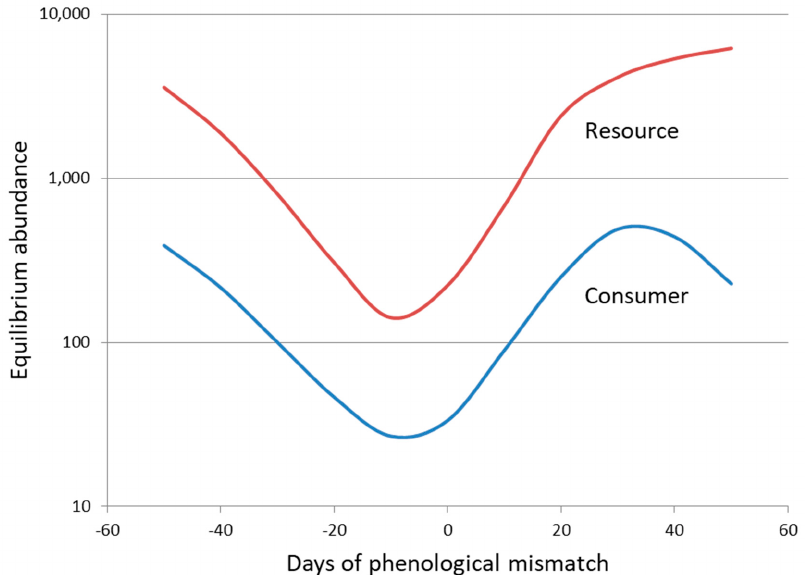
Figure 3. The influence of phenological mismatch on the equilibrium abundance of consumer and resource populations for a model in which within-year dynamics is continuous, between-year dynamics is discrete, and phenological mismatch is represented by a difference in the mean dates of normal distributions for recruitment of consumer and resource populations. Redrawn after [68].